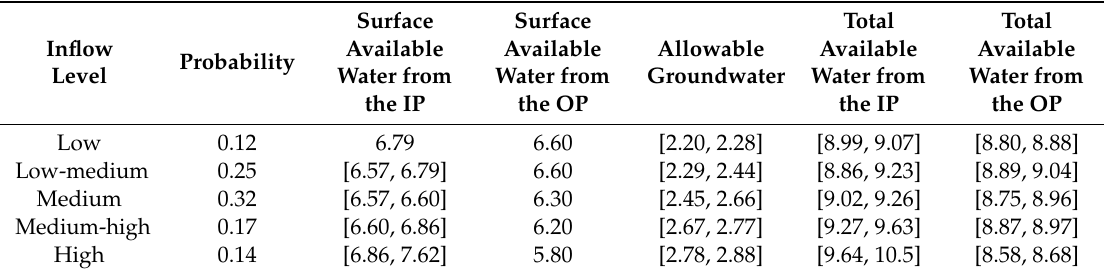
Table 3. Water availabilities for irrigation under di ff erent inflow levels (10 8 m 3 ).